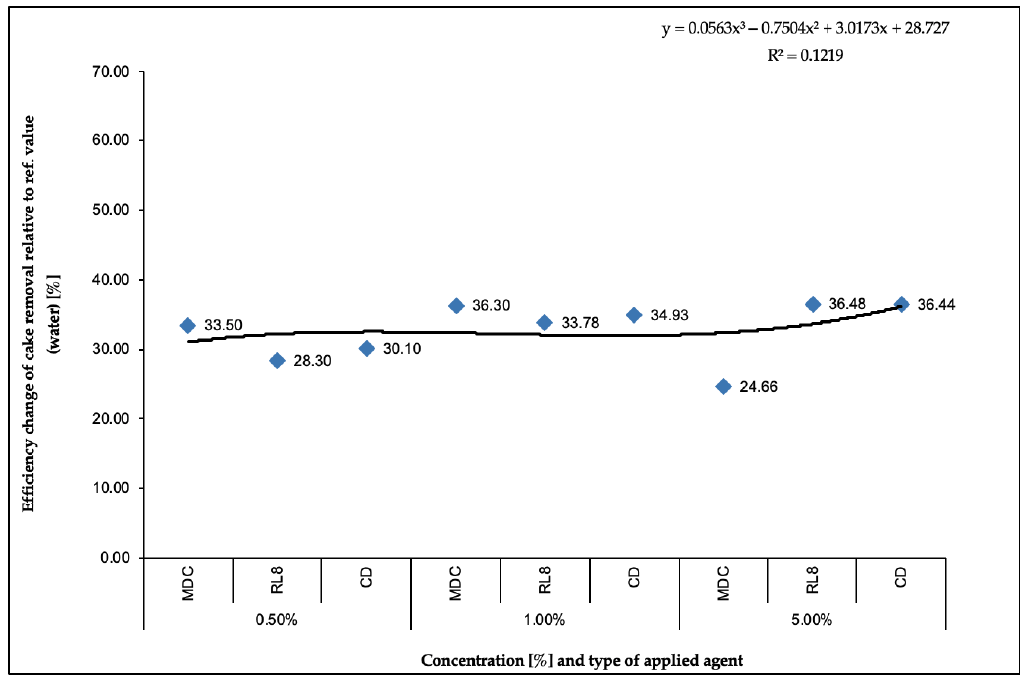
Figure 9. Efficiency change of cake removal with traditional agents, depending on the applied concentration. Water was used as a reference value.